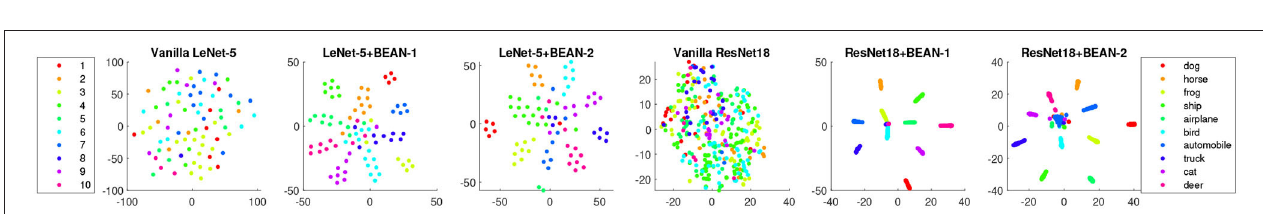
FIGURE 4 | The strong association between neuronal assemblies and neurons’ class selectivity index with BEAN regularization on both MNIST (left) and CIFAR-10 (right) datasets. Each point represents one neuron and the color represents the class where the neuron achieved its highest class-conditional mean activity in the test